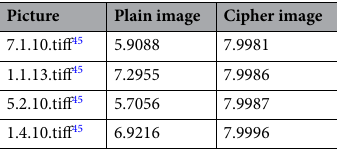
Table 5. Information entropy of the plain image and ciphered image.